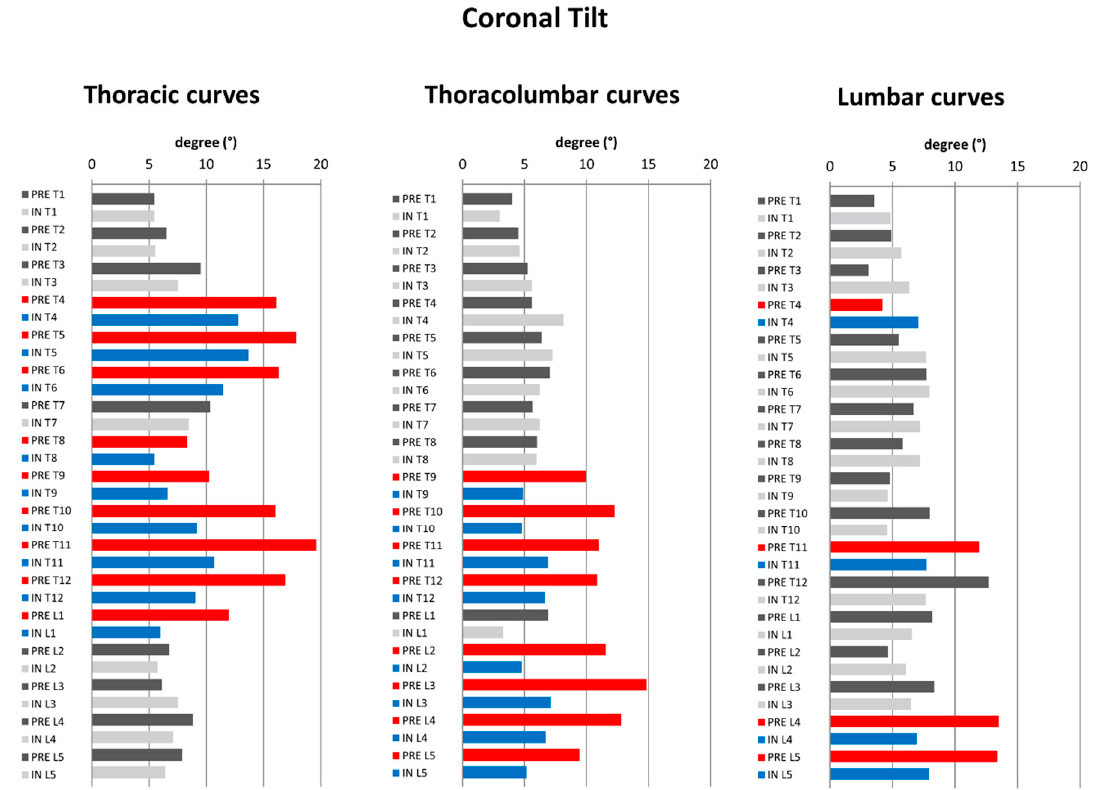
Figure 4. Diagrams illustrating the pre- to in-brace changes in vertebral coronal tilt (T1–L5) pertaining to structural curve type. Dark grey: pre-brace, light grey: in-brace. Statistically significant changes in pre- to in–brace vertebral orientations are depicted in red (pre-brace) and blue (in–brace) ( p ≤ 0.05).